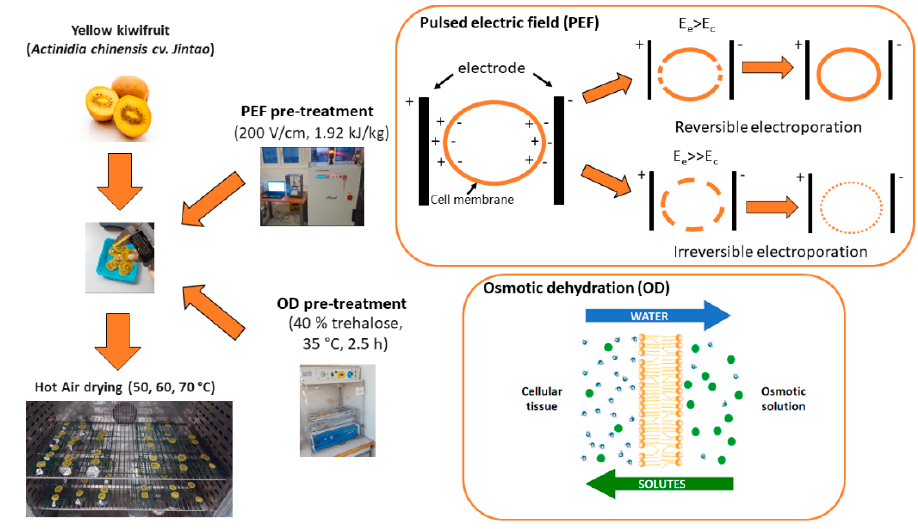
Figure 5. Application of pulsed electric field (PEF) and osmotic dehydration (OD) as a pre-treatment before hot air drying—mechanism of action.